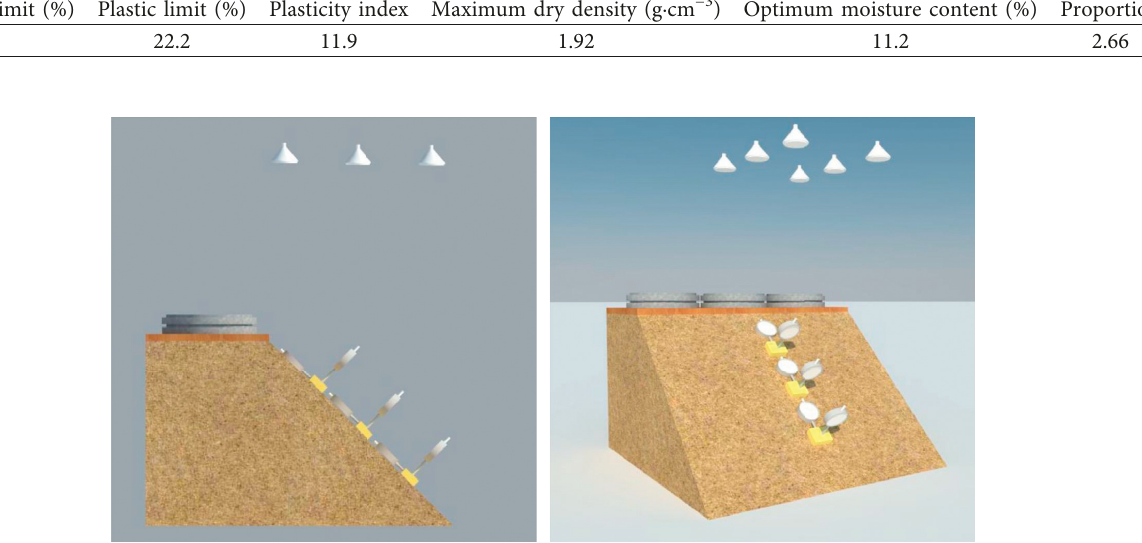
Figure 2: Test arrangement